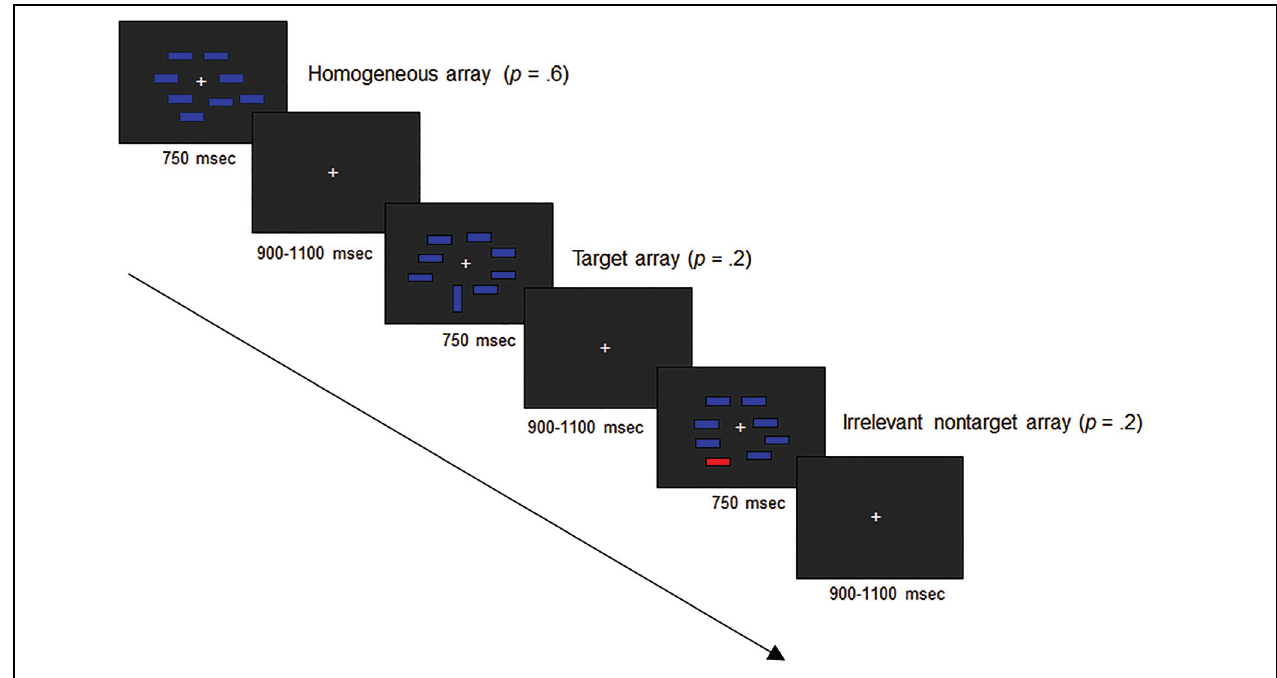
FIGURE 1 | Schematic diagram of the visual search arrays used in the event-related brain potential (ERP) experiment. The arrow represents the time passage.